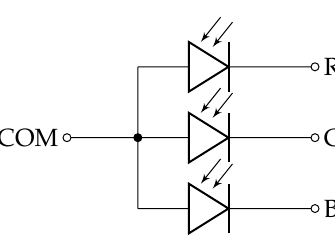
Figure 13. Through-hole RGB LED schema: a common anode pin on the left side COMand three cathode pins on the right, where each one corresponds to a specific color (red, green and blue). In fact, CSK modulation is used to map the information into red, green and blue color intensities and to make the appearance of the light source as white light by a proper dimming schema;